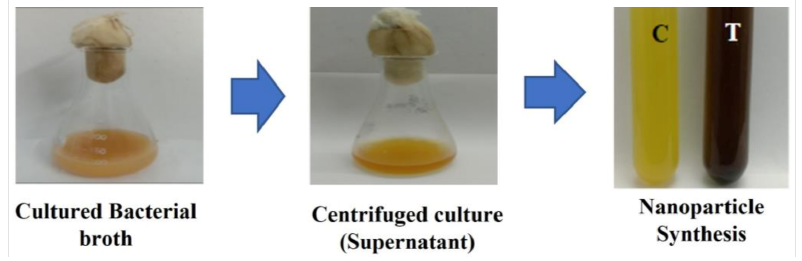
Figure 16. Biosynthesis of